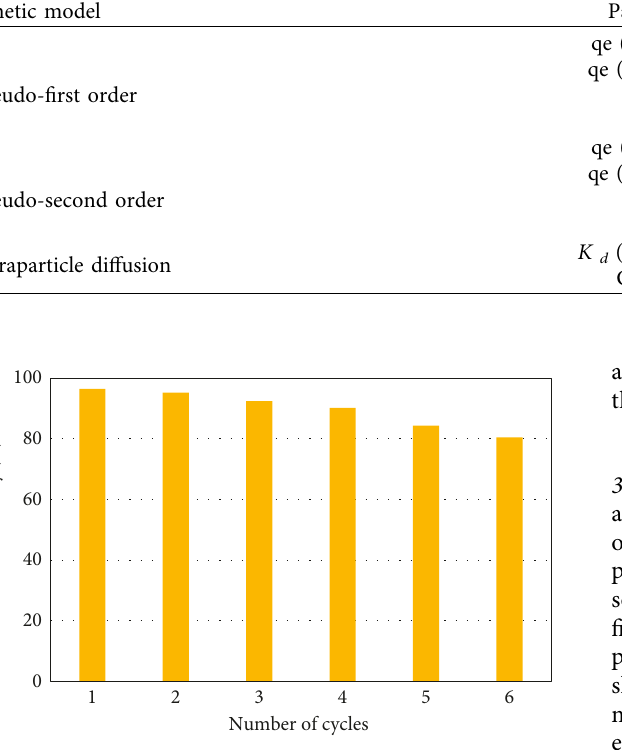
Figure 14: Regeneration and reuse of the nanocomposite adsor- bent (BMNC) for Cr(VI) ions removal from water